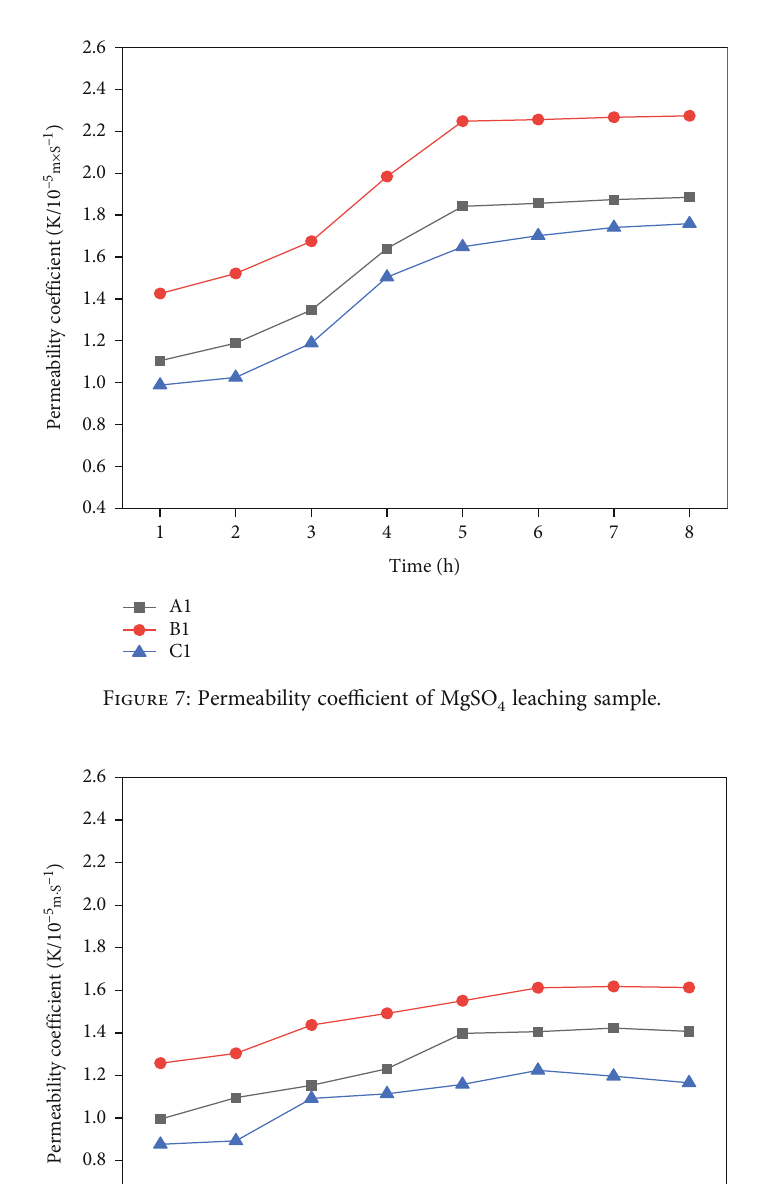
Figure 8: Permeability coe ffi cient of deionized water leaching